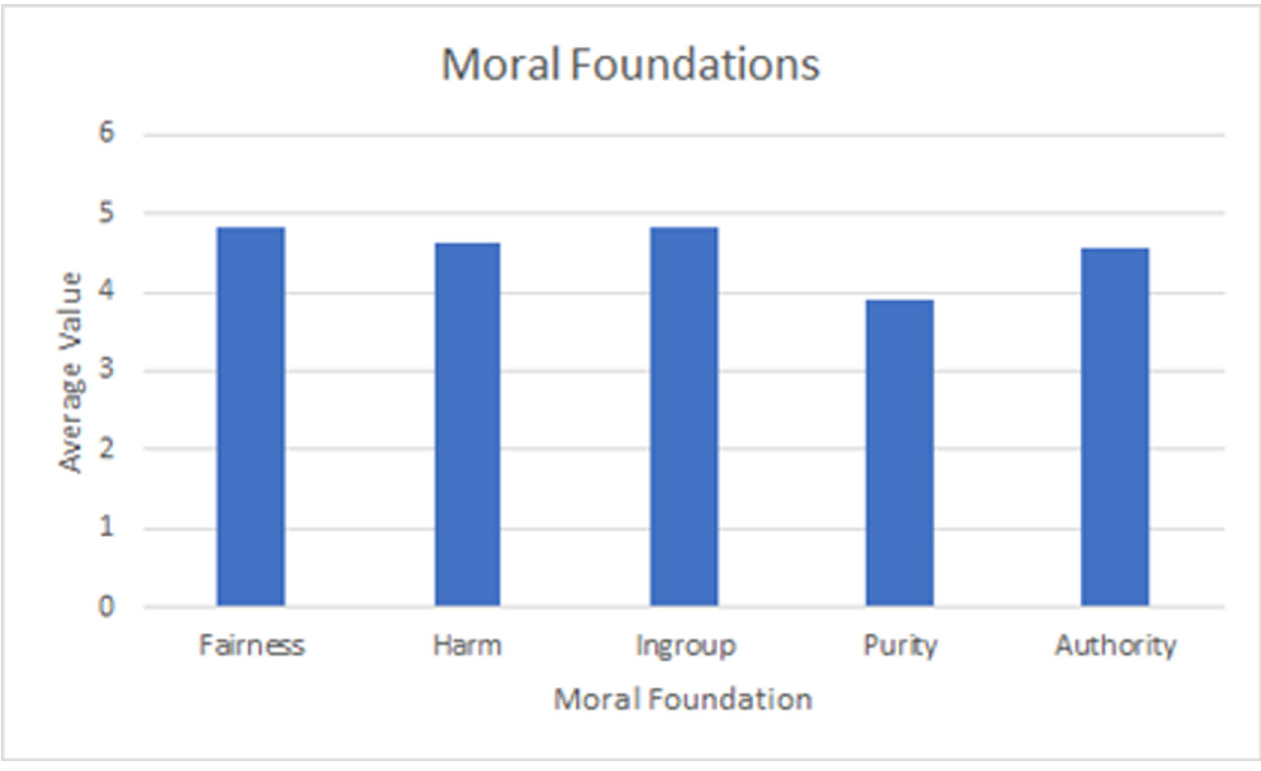
Fig 1. Moral foundations of the paramilitary organization.